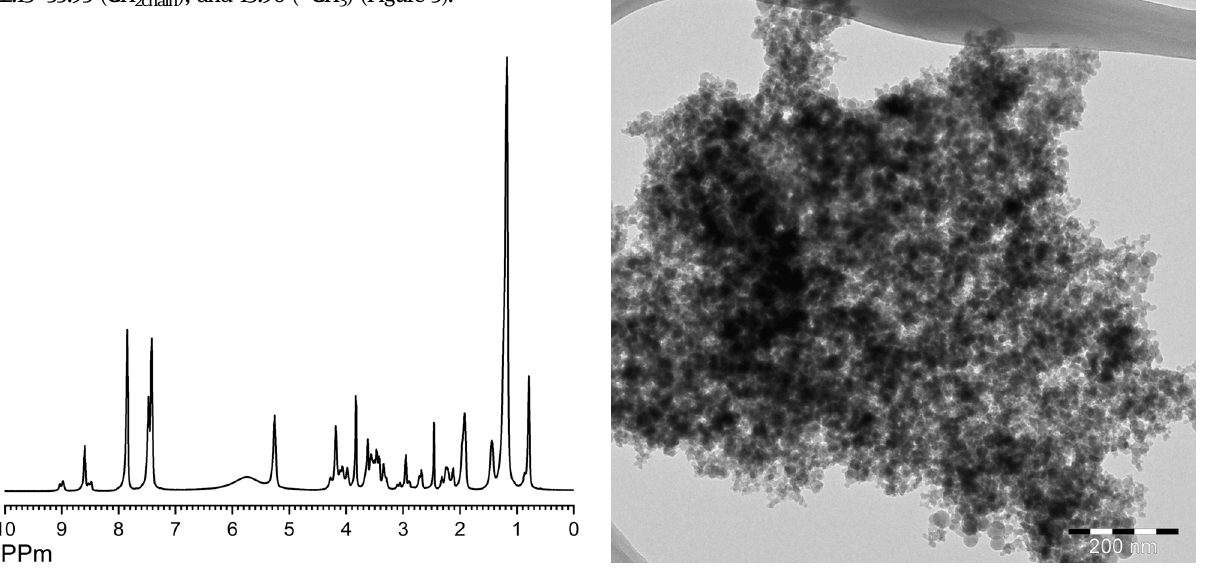
Figure 2: 1 H NMR spectra of ROHA.